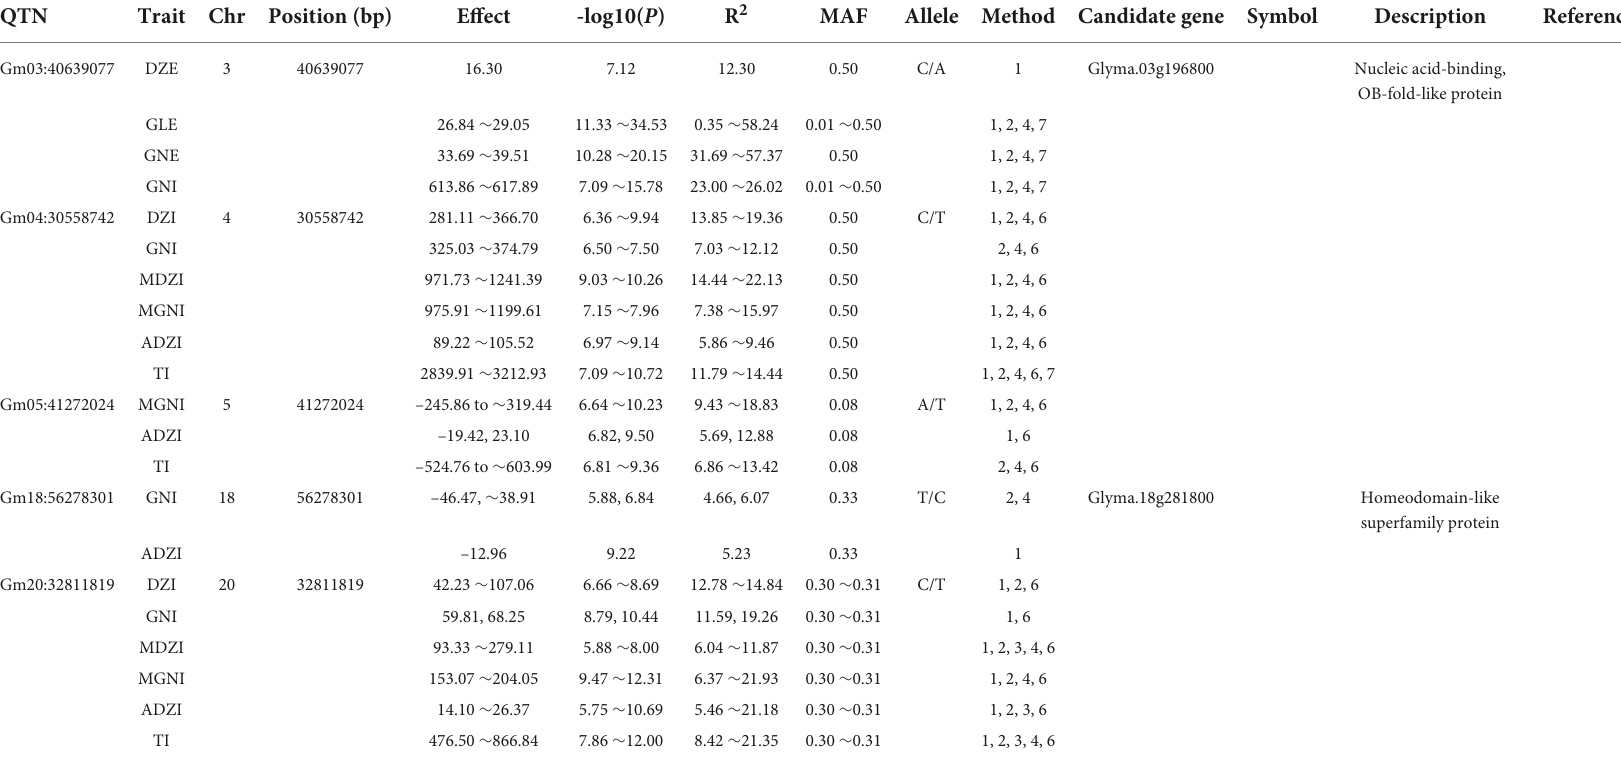
TABLE 3 Information about co-detected QTNs for isoflavone contents in 2021 using MLM-based models. QTN Trait Chr Position